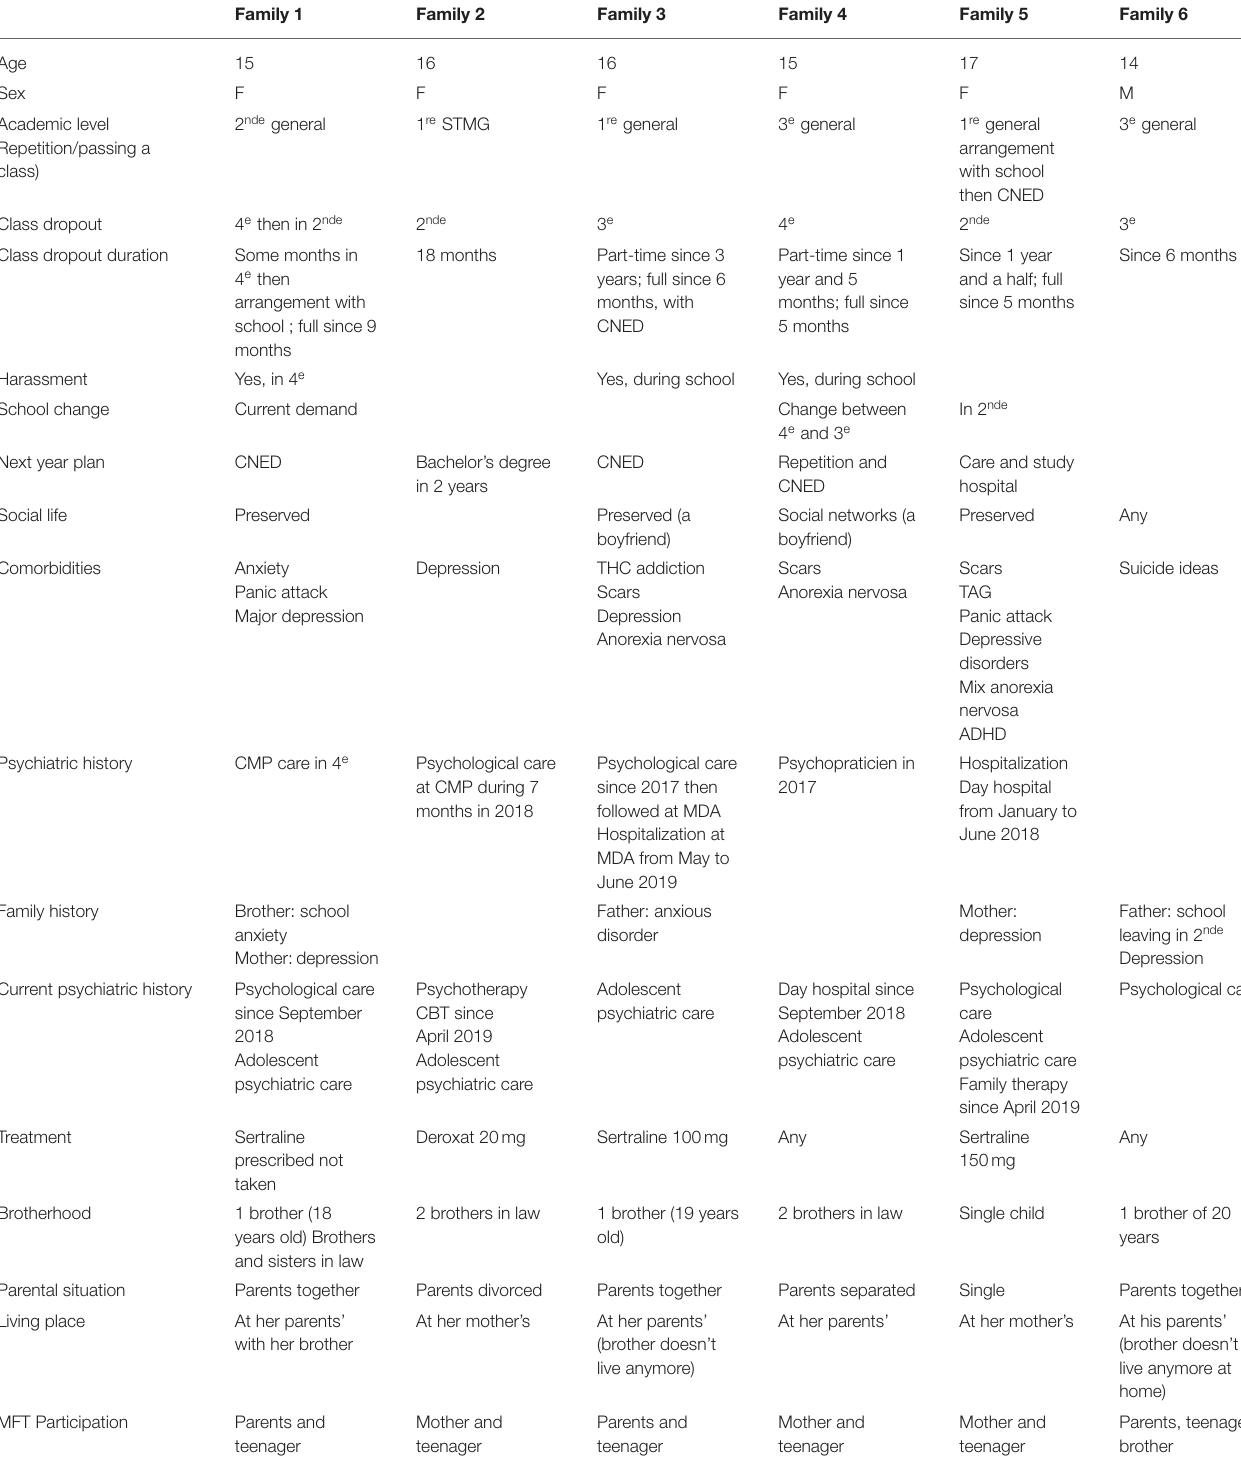
TABLE 3 | Participants’